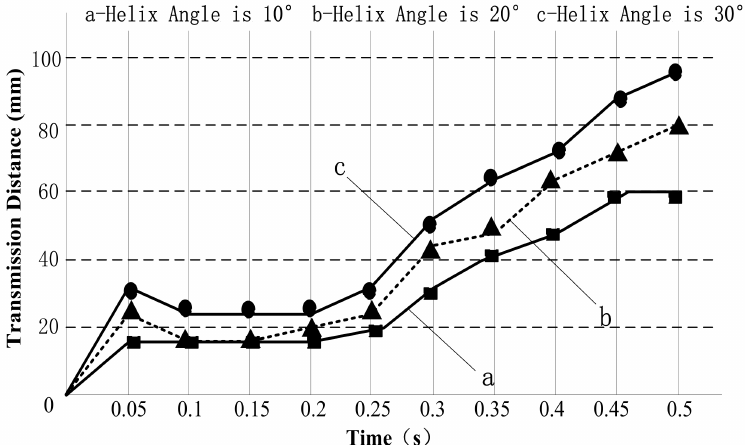
Figure 10. Transmission distance with different